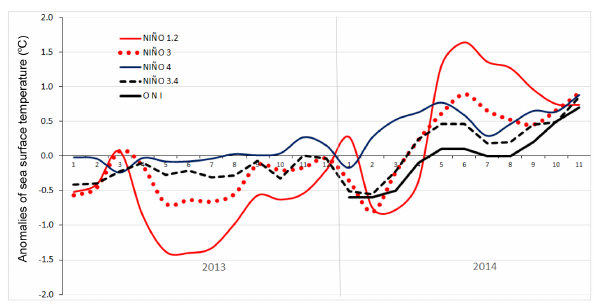
Figure 2. Evolution of the sea surface temperature anomalies in different areas of the tropical Pacific and ONI during 2013 until November